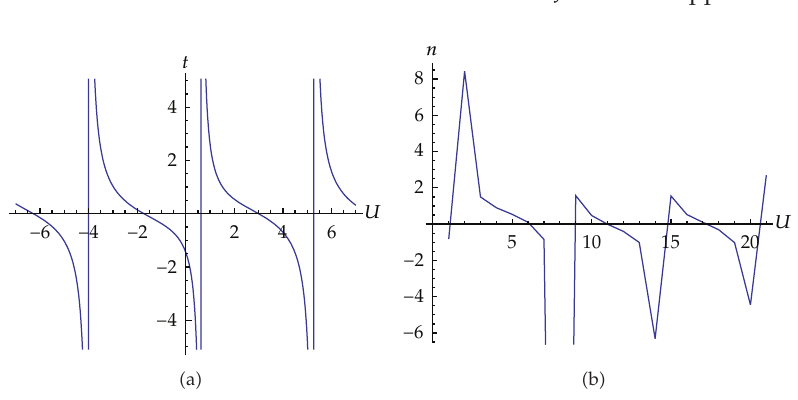
Figure 3: (cid:5) a (cid:6) represents the Jacobi elliptic solution (cid:5) 3.54 (cid:6) when m (cid:9) 0 . 5, c 1 (cid:9) 0 . 4, C (cid:9) − 0 . 6, d (cid:9) 0 . 3, n (cid:9) 2. (cid:5) b (cid:6) represents the Jacobi elliptic solution (cid:5) 3.54 (cid:6) when m (cid:9) 0 . 5, c